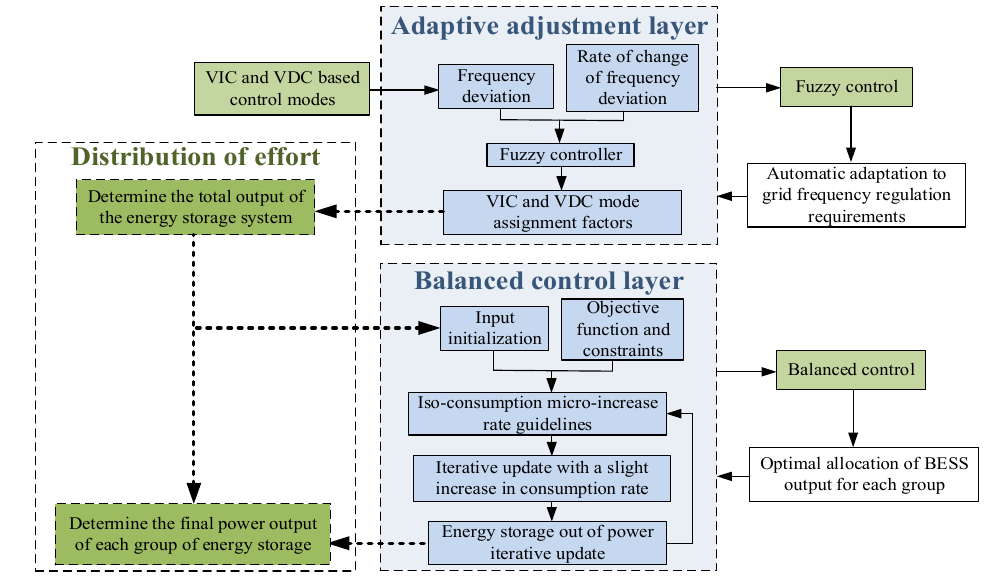
Figure 3. Two-layer control structure in dual-signal mode.